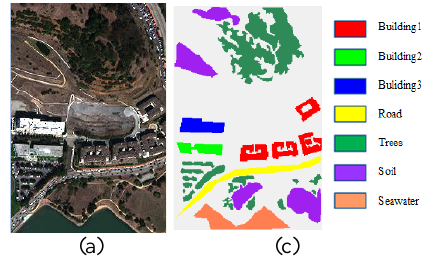
Figure 3. Bayview Park data set. (a) RGB composite image of bands. (c) Ground truth map.